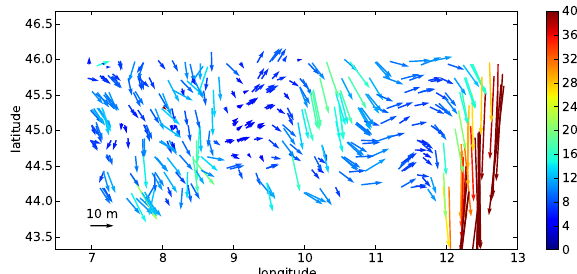
Figure 6: Evaluation of the bundle block adjustment against checkpoints extracted from the Euro-Maps 2D mosaic. Each ar- row represents the mean X and Y error of a stereo pair. RPC corrections for all scenes were